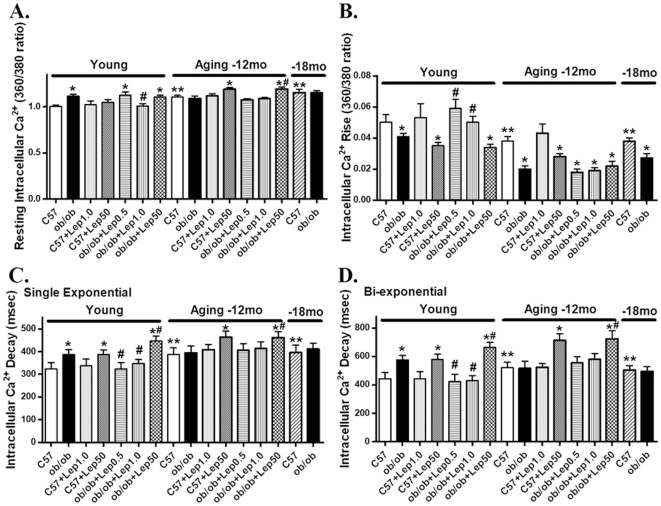
Intracellular Ca2+ transient properties of
cardiomyocytes freshly isolated from young (4-month-old) and aging (12-
or 18-month-old) lean (C57) and ob/ob mice treated with
or without leptin (0.5, 1.0 and 50 nM) for 4 hrs.A: Resting intracellular Ca2+ fluorescence intensity;
B: Rise in intracellular Ca2+ fluorescence intensity
in response to electrical stimuli; C: Single-exponential
Ca2+ transient decay rate and D: Bi-exponential
Ca2+ transient decay rate. Mean ±
SEM, n = 36–38 cells from 3
mice per group, * p<0.05 vs. respective
C57 group, ** p<0.05 vs. young
C57 group, # p<0.05 vs. respective
ob/ob group.